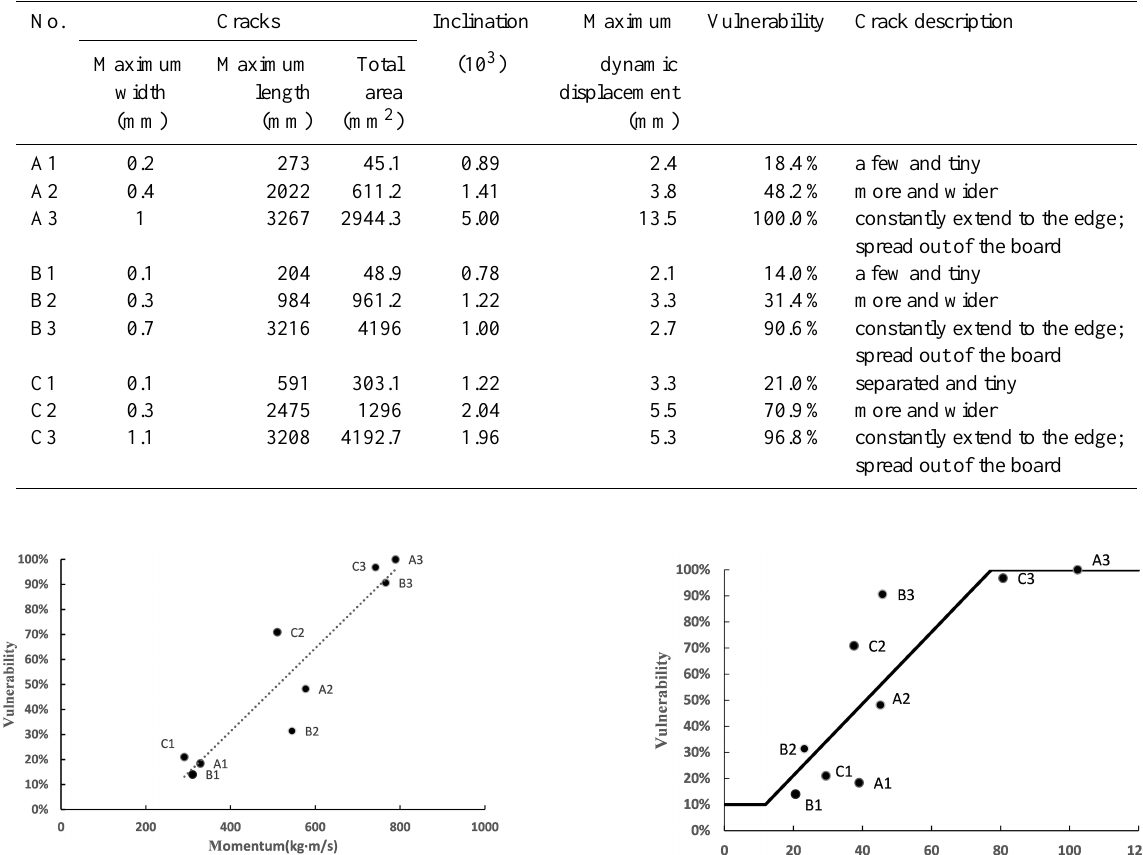
Table 4. Statistical table of the influence indicators.